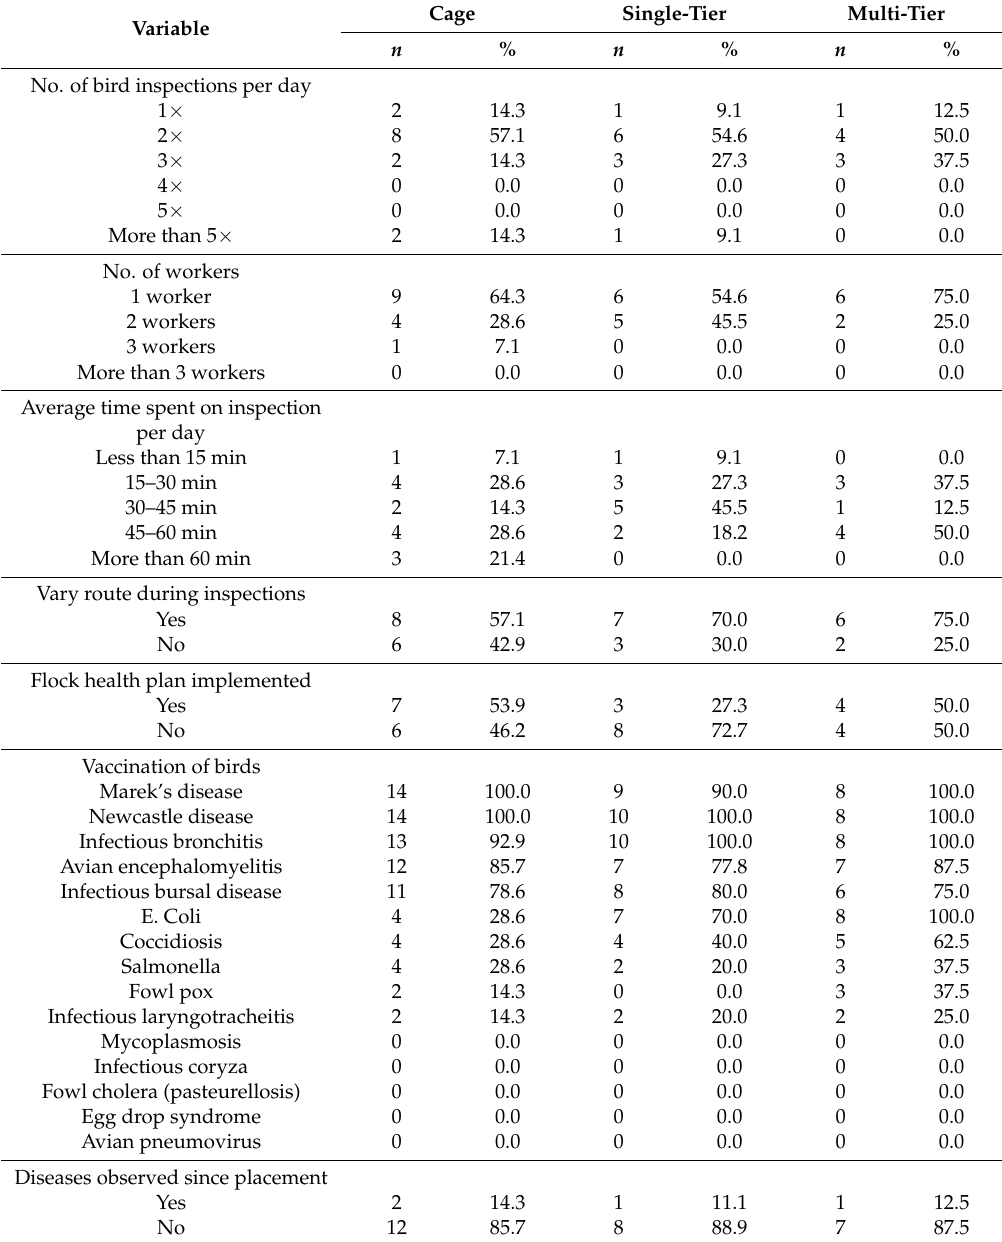
Table 8. Frequency of flock health management practices for 33 pullet flocks placed between May and November 2017 according to housing system (cage n = 14, single-tier n = 11, multi-tier n = 8) in Canada. Cage Single-Tier Multi-Tier Variable n % n % n